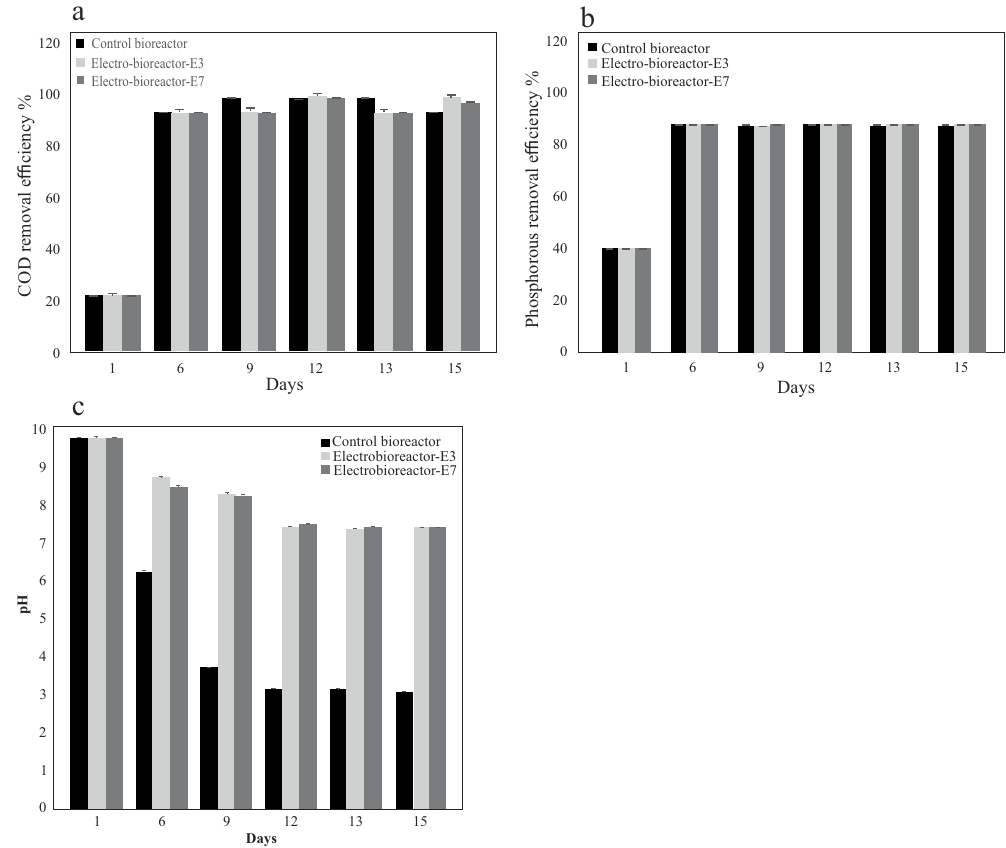
Figure 1. Removal efficiencies of ( a ) COD, ( b ) PO 43 − -P in serially passaged control bioreactor and electro- bioreactors E3 and E7 operated at current densities 3 and 7 Am − 2 respectively. Overall, the removal efficiency of sCOD and PO 43 − -P in electro-bioreactors is attributed to the effects of electrochemical processes in addition to biodegradation. ( c ) pH variations in serially passaged control bioreactor and electro-bioreactors E3 and E7 operated at current densities 3 and 7 Am − 2 respectively. Results confirmed that serially passaged electro- bioreactors maintained the pH which in turn stabilized the medium for the bacteria to be